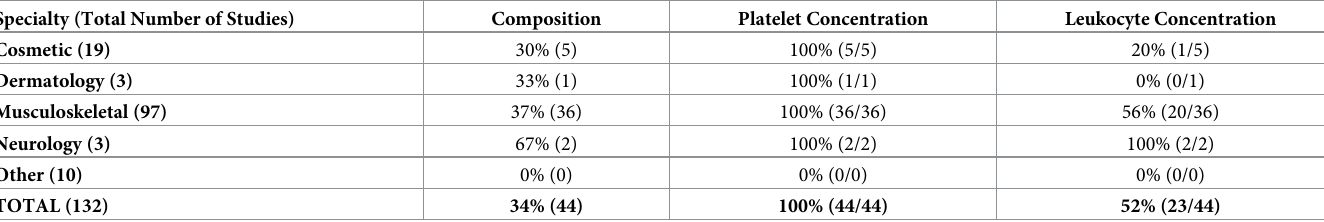
The majority of subjective outcomes reported consisted of patient-reported outcome measures (PROMs), including visual analogue scale (VAS) pain scores and joint- and disease-specific functional outcome measures. A variety of validated and non-validated scores were used depending on the condition being studied. The vast majority (93%) of MSK studies used at least one PROM in their study (Table 4). Of these, 66% of them reported scores from PROMs favoring PRP over other treatment groups. In contrast, only 49% of studies from all other spe- cialties used a PROM to assess outcomes (p < 0.01). Table 2. Percentage of studies reporting details on composition of platelet-rich plasma